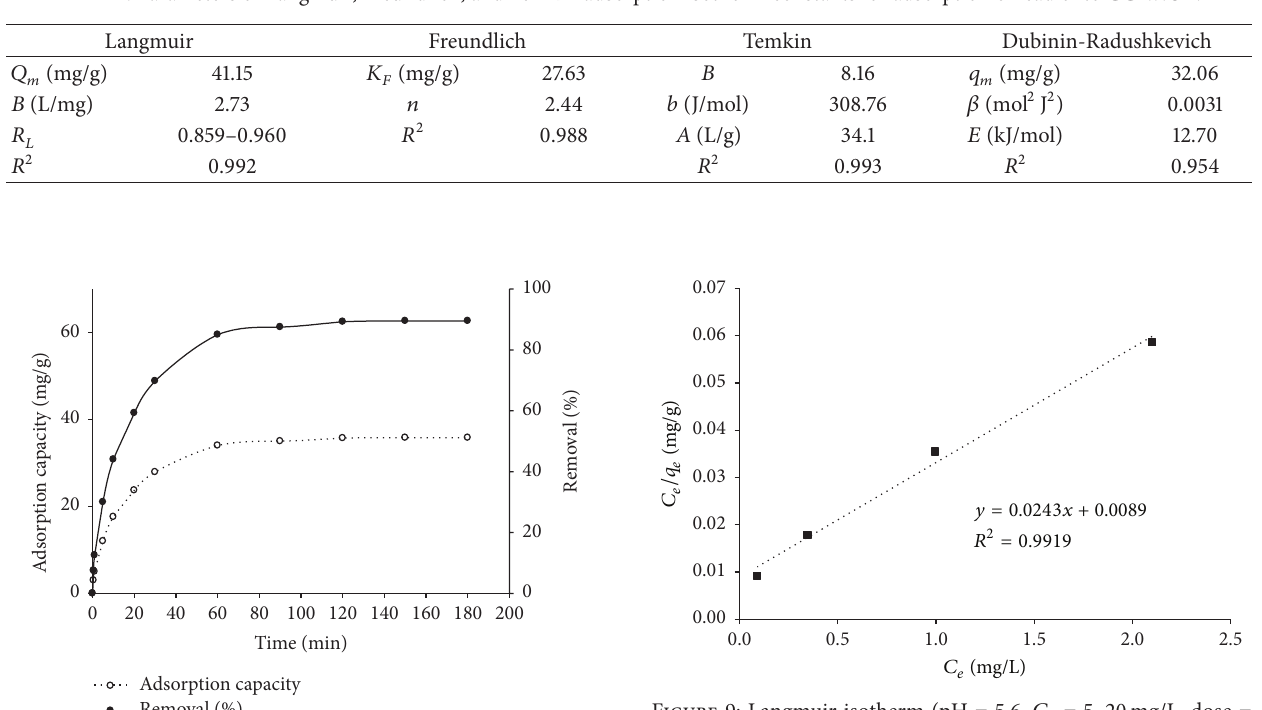
Figure 9: Langmuir isotherm (pH = 5.6, 𝐶 0 = 5–20 mg/L, dose = 0.5 g/L, contact time = 180 min, and temperature = 30 ∘ C).